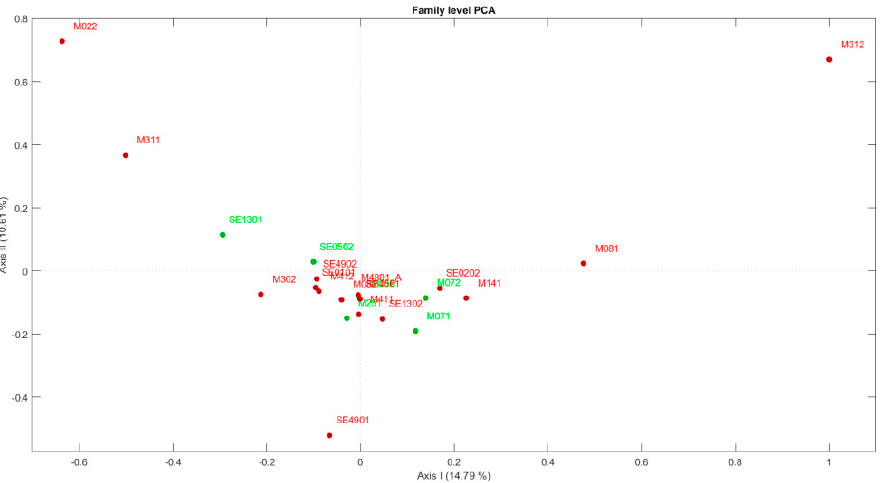
Figure 11. The results of PCA at the family level. Green: OSA − atherosclerosis. Red: OSA + atherosclerosis.